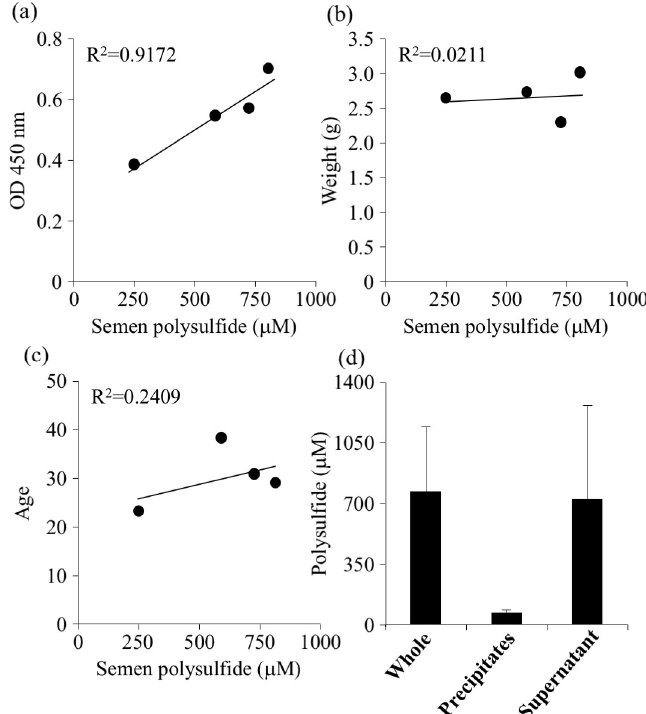
Figure 3. Comparing seminal polysulfide with related factors. Polysulfide levels in seminal fluids were investigated for their correlation with ( a ) sperm activity, ( b ) weight of total semen, ( c ) age. ( d ) Semen was separated by differential centrifugation at 2000× g for 5 min. The precipitate was washed with PBS 10 times and dissolved to the initial volume by PBS. Polysulfide level was measured by EMSP.